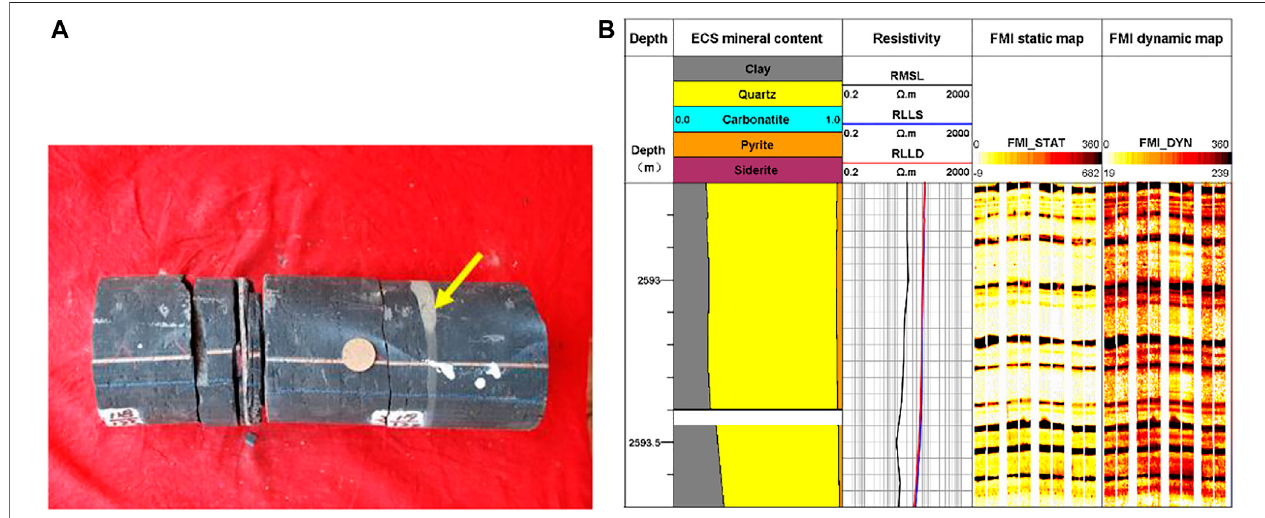
FIGURE 1 | Core characteristics and FMI image of the thin, low-resistivity layer: (A) core sample; (B) FMI image.